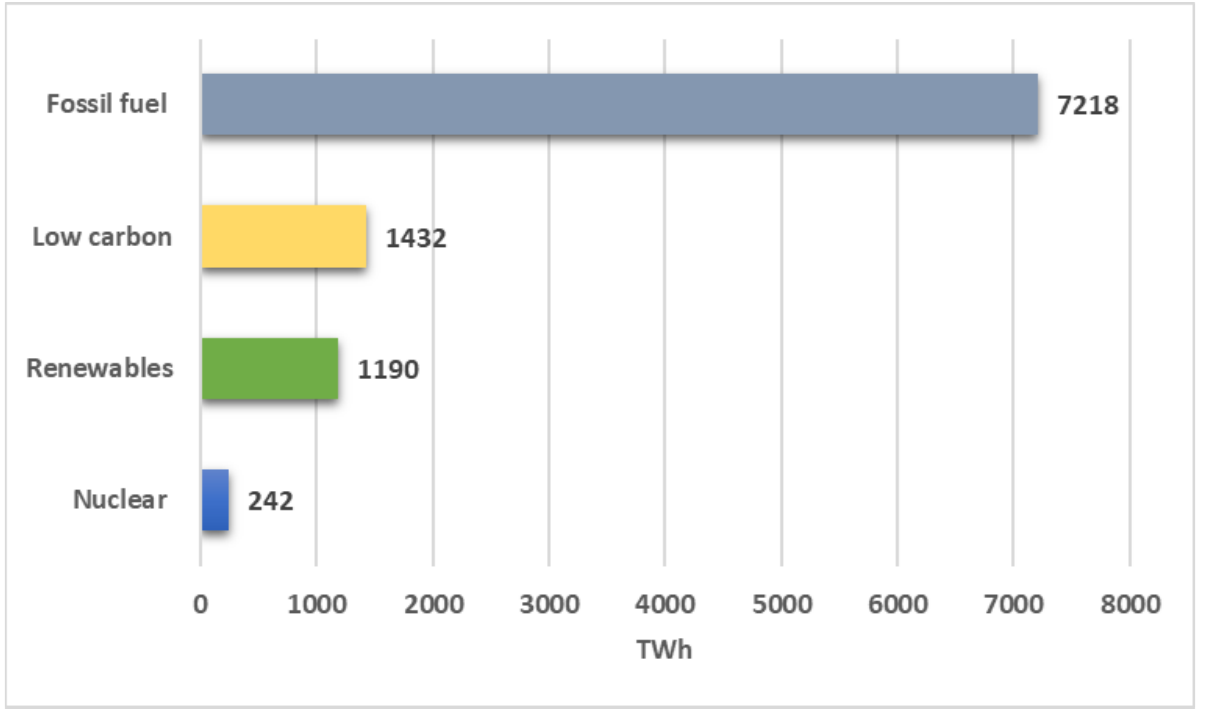
Figure 2. Primary energy consumption from fossil fuel vs. other fuels; data adapted from [25].